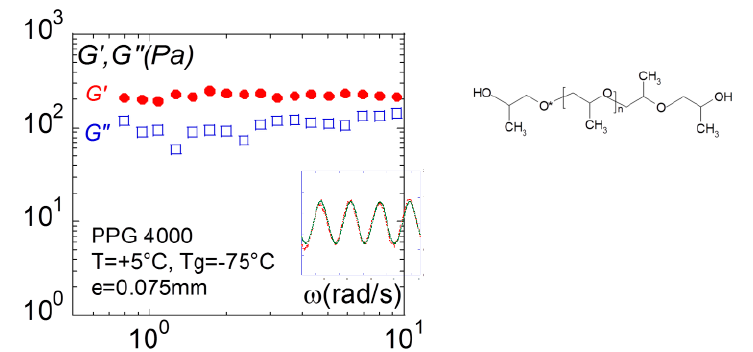
Figure 13. Frequency dependence of the elastic G’( ω ): ● and viscous moduli G”( ): □ , measured for a glass former liquid (polypropyleneglycol (PPG4000), M W = 4000, Tg = − 75 °C) at T = +5 °C (0.075 mm gap thickness–alumina plate-plate fixtures). The insert shows the superposition of the strain (green points) and the stress (red points) waves highlighting the instant response of the liquid.